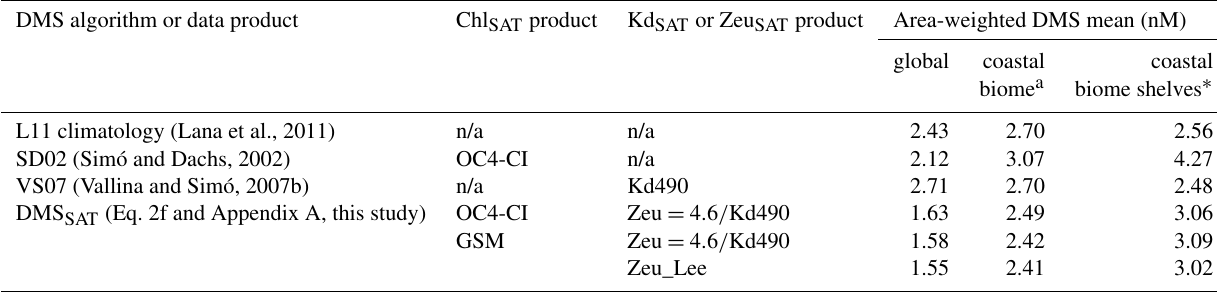
Table 4. Mean area-weighted DMS concentrations for different climatological datasets and domains. Different results for the DMS SAT algorithm were obtained using alternative approaches for retrieving chlorophyll a concentration (Chl SAT ) and the euphotic layer depth (Zeu SAT ). Results (based on 1 ◦ × 1 ◦ gridded data) are shown for the global domain, the Longhurst Coastal biome and, within it, areas shallower than 200m (shelves); n/a: not